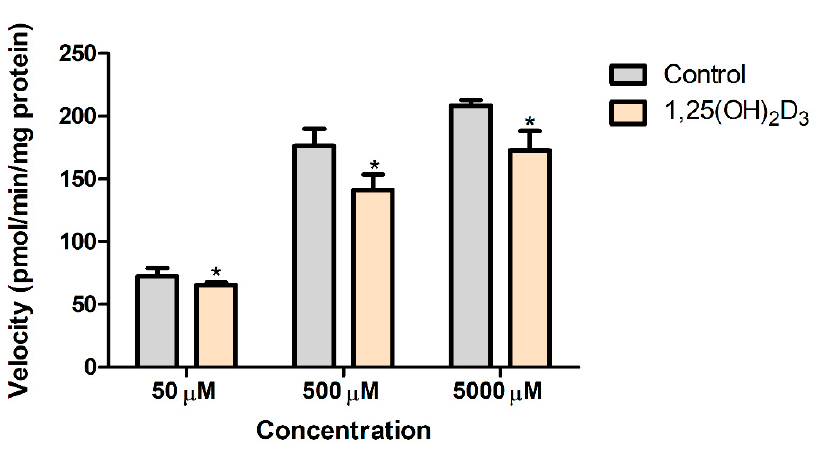
Figure 5. Mean amount of NAPA (pmol/min/mg protein) formed in vitro in S9 fractions of controls and 1,25(OH) 2 D 3 -treated rats ( n = 4–5). * Indicates p <